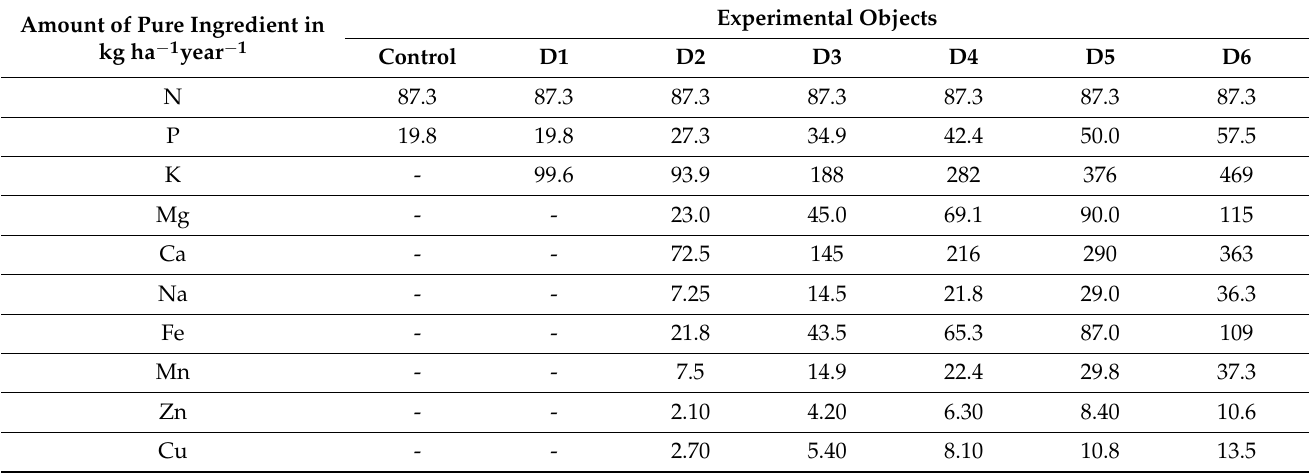
Table 1. The amount of nutrients supplied to the soil with fertilisers (kg ha − 1 year − 1 ). Amount of Pure Ingredient